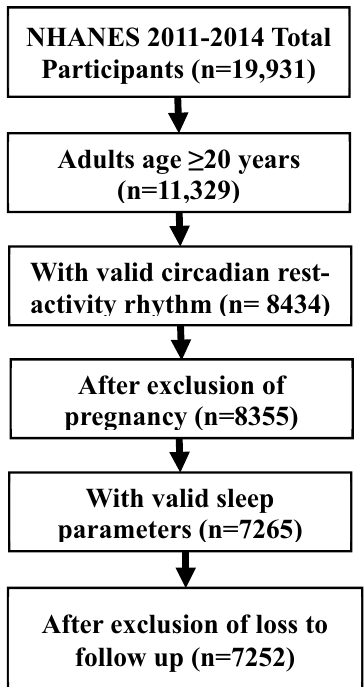
Figure 1. Flowchart for inclusion of study